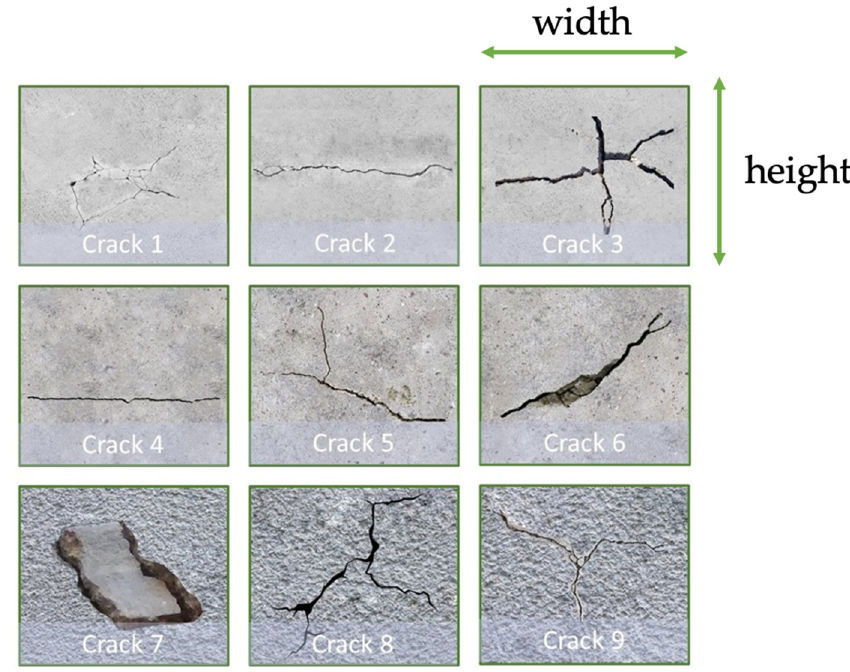
Figure 5. Di ff erent types of cracks in the training dataset.